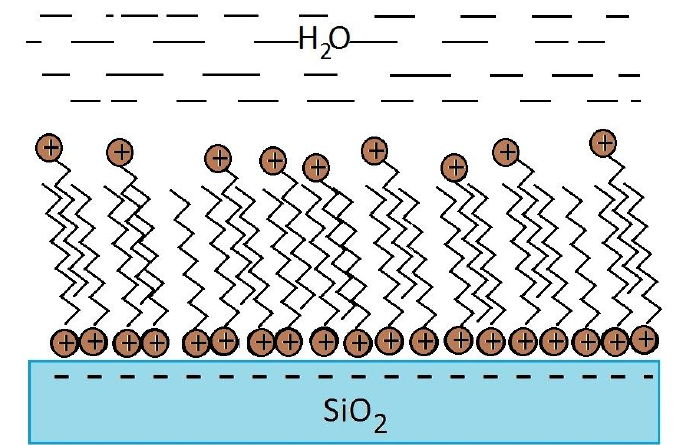
Figure 7. Model of adsorption bi-layer of C10 amine.